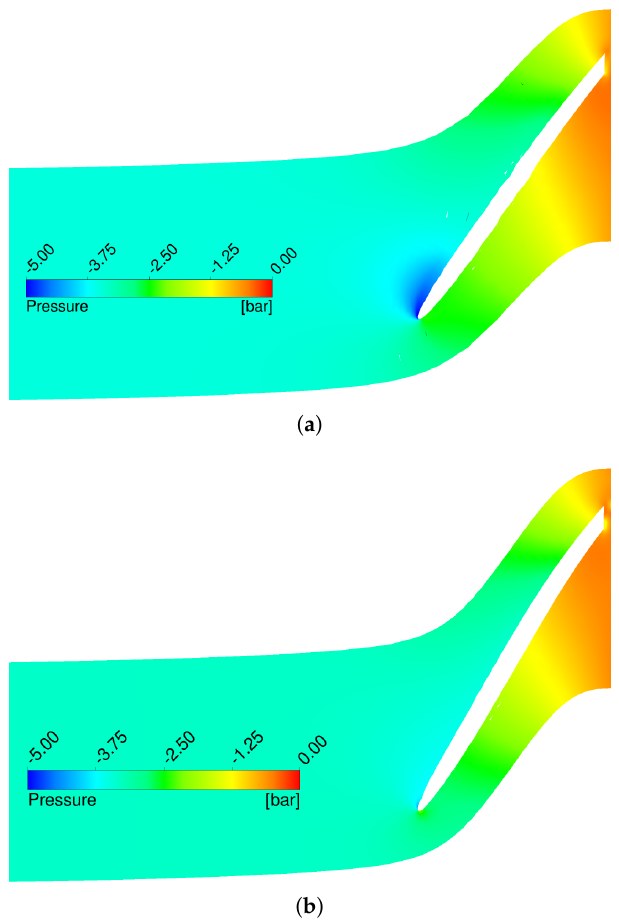
Figure 17. Static pressure field in the blade to blade view at 50% of the span for the baseline ( a ) and optimized ( b )